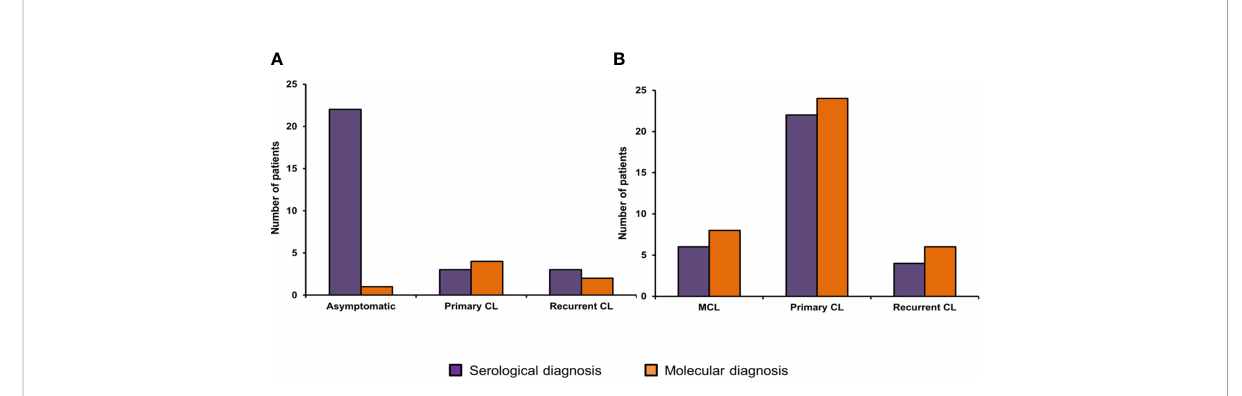
FIGURE 1 Clinical manifestation distribution of patients who tested positive for TL using serological (ELISA) and molecular diagnosis (kDNA qPCR). (A) Patients of Corte de Pedra. (B) Patients of the UHB. Legend: CL, Cutaneous leishmaniasis, MCL, Mucocutaneous